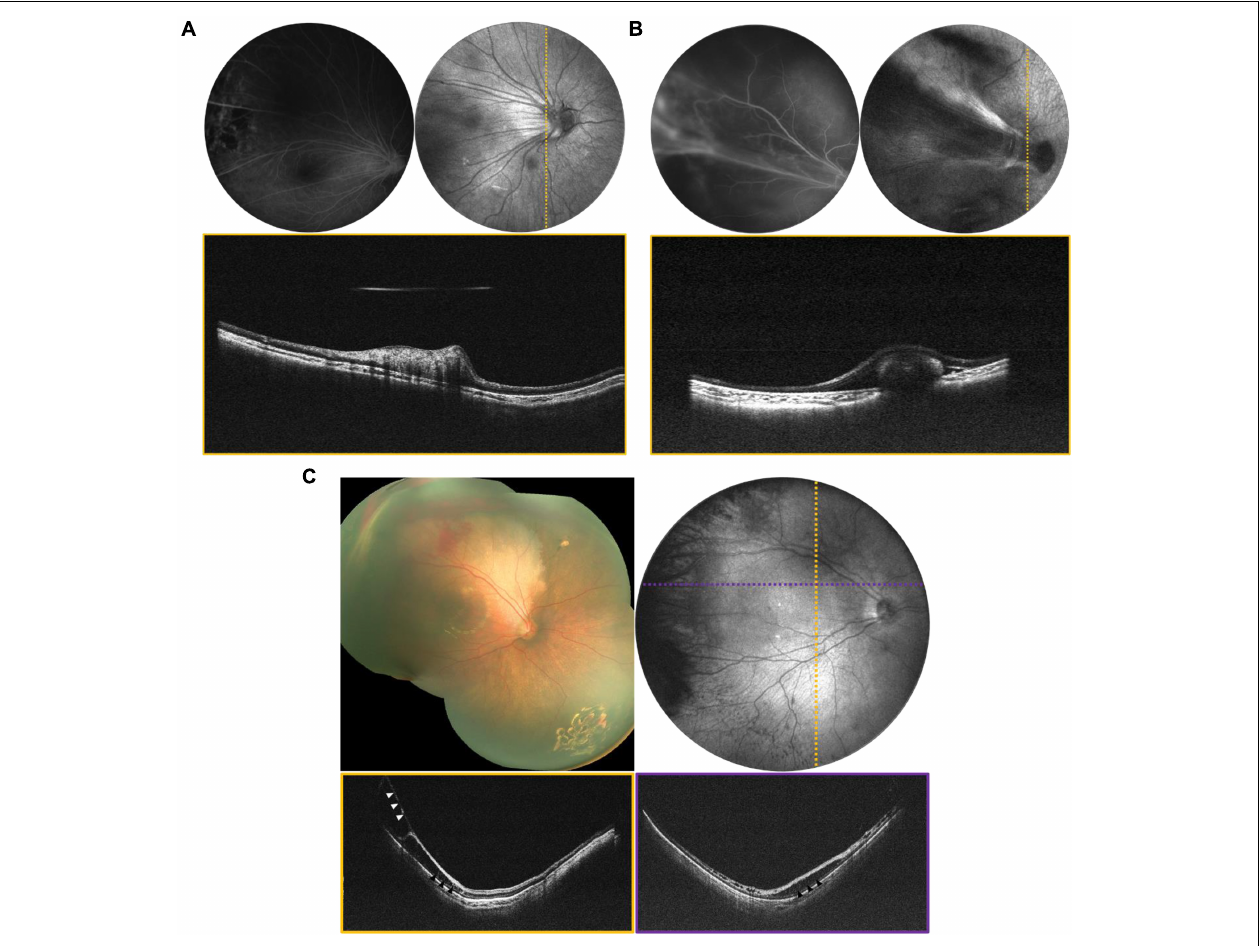
FIGURE 2 | Tractional retinal disease evaluated via OCT. (A) Tractional retinal fold secondary to FEVR in a 3-year-old patient. (B) Tractional fold with peripheral detachment secondary to IP in a 1-year-old patient. For (A,B) , top left is the FA, top right is the mean-intensity en face projection taken with the 55 ◦ FOV configuration, and bottom is the B-scan corresponding to the dotted line. (C) Stage 4a ROP in a 4-month-old born at 24 weeks gestation. Top left image is a montage of fundus photographs. Top right is a 105 ◦ FOV OCT en face with dotted lines indicating the locations of the color-coded B-scans in the bottom row. Vitreoretinal traction is indicated by white arrows, and areas of schisis are indicated by black